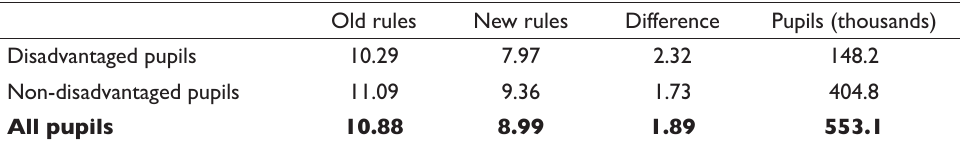
Table 1: Mean number of GCSEs (or equivalents) entered by disadvantaged and non-disadvantaged pupils reaching the end of Key Stage 4 in maintained mainstream schools in 2014 Old rules New rules Difference Pupils (thousands) Disadvantaged pupils 10.29 Non-disadvantaged pupils